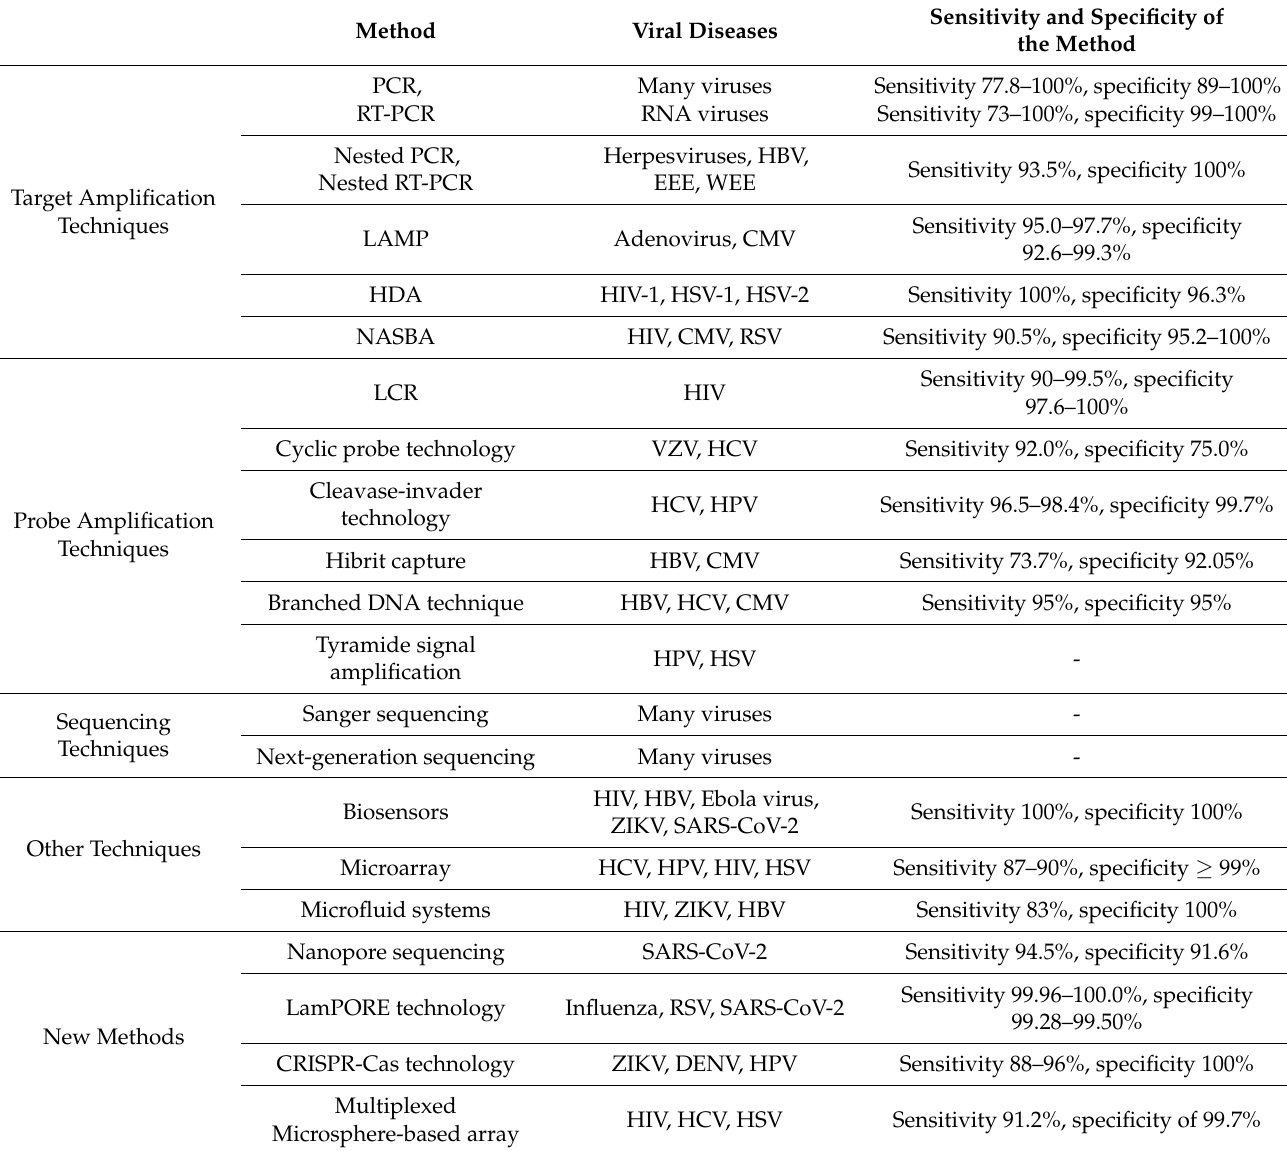
Table 1. Summary of molecular techniques used in the diagnosis of viruses